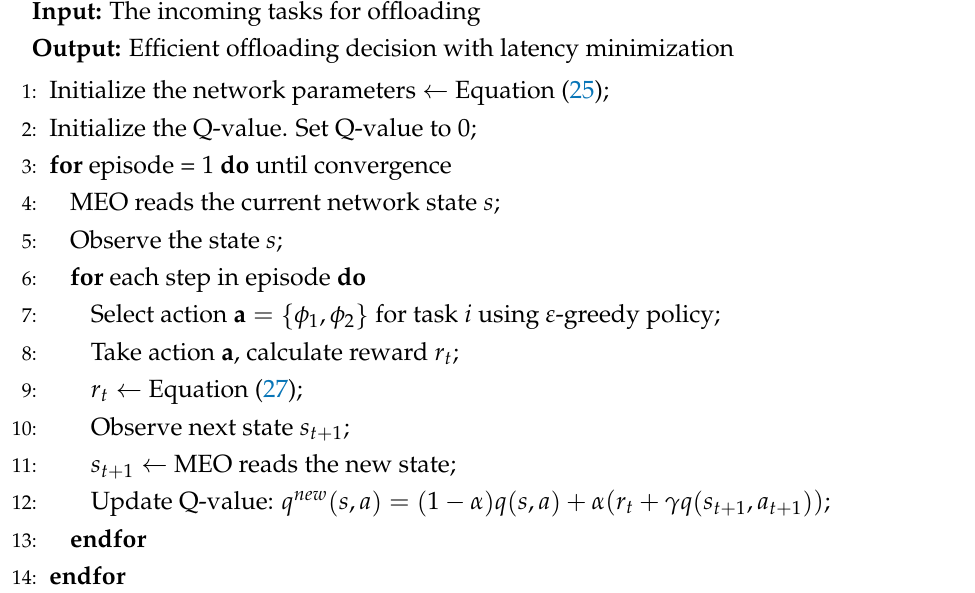
Algorithm 2 SARSA-Supported Task Offloading